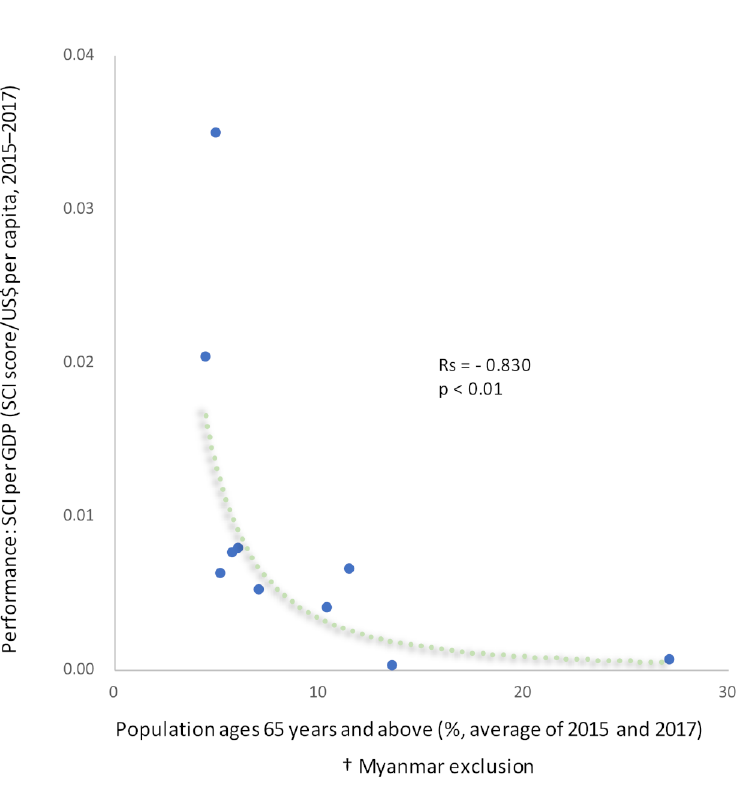
Figure 5. Trends in SCI and performance (economic level: GDP) with respect to the aging rate (percentage of the population aged 65 years and above). ( Top ) Note: UHC, universal health coverage; SCI, service coverage index. ( Bottom ) Note: SCI, service coverage index. (†) Myanmar has a different quadrant (dimension) because it is a